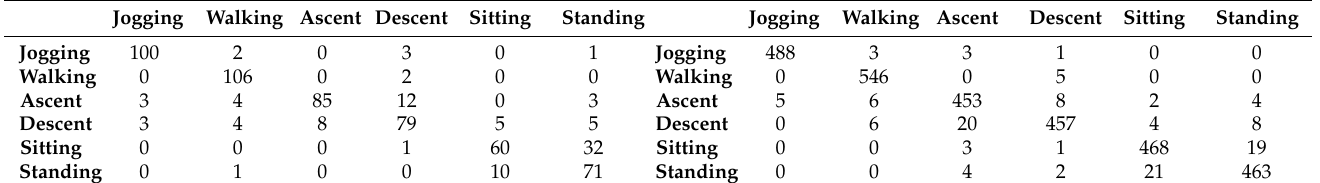
Table 8. Confusion matrix of WISDM dataset-ResNet18 (initial results—left, final results—right).